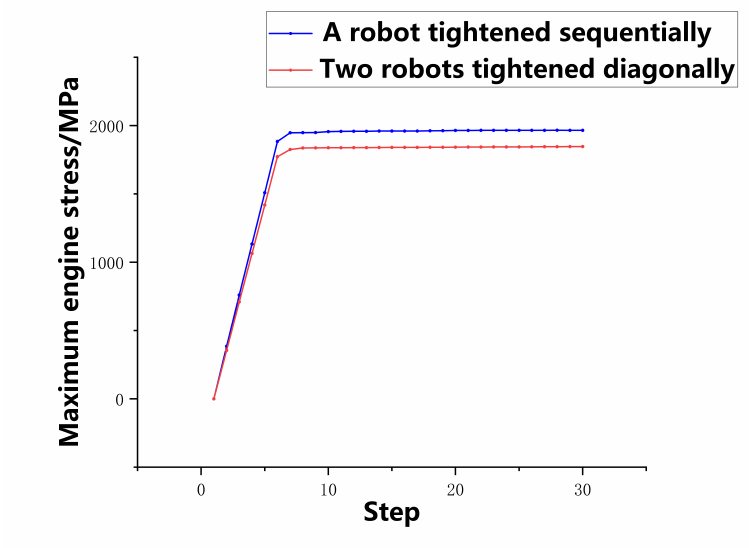
Figure 15. Comparison of the maximum stress of the engine before and after optimization.